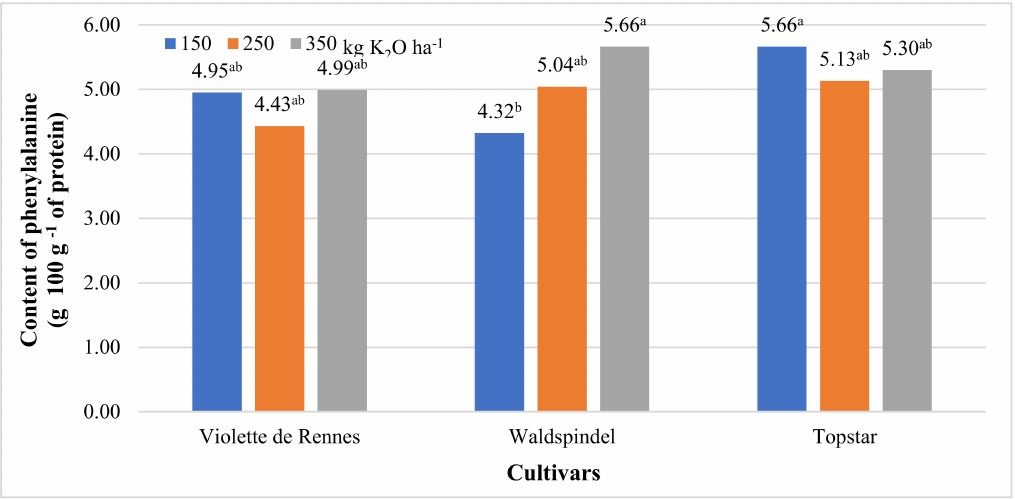
Figure 4. The e ff ect of potassium fertilization on the phenylalanine content of tubers in the analyzed Jerusalem artichoke cultivars. Means with the same letters do not di ff er significantly at p ≤ 0.05 in Tukey’s test. The absence of letters denotes non-significant main e ff